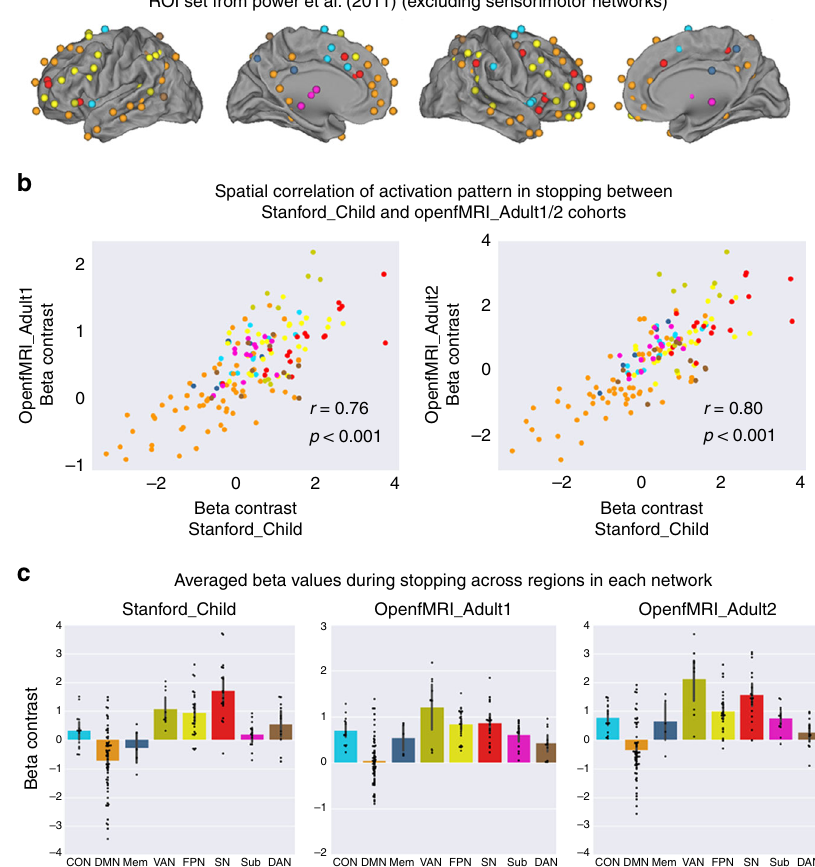
Fig. 4 Similarity of network activation in children and adults. a ROIs were de fi ned using functional networks implicated in cognition, perception, and control from an independent study by Power et al. 40 . Each ROI was color-coded based on the functional network to which it belongs. ROIs from sensorimotor networks were excluded in the analysis. b Brain activation patterns elicited by stopping (SuccStop versus Go) in children were signi fi cantly correlated with activation patterns in the two different adult cohorts. SN, Sub, FPN and VAN nodes showed the greatest activation during stopping in children and adults. DMN nodes showed the greatest deactivation during stopping in children and adults. c Activation levels (Beta-weights) in large-scale brain networks during stopping in children and adults. Error bars represent standard deviation. Activations were averaged across regions in each functional networks. Networks are color-coded and the same coding was used across all the panels: CON: cyan; DMN: orange; Mem: navy blue; VAN: green yellow; FPN: